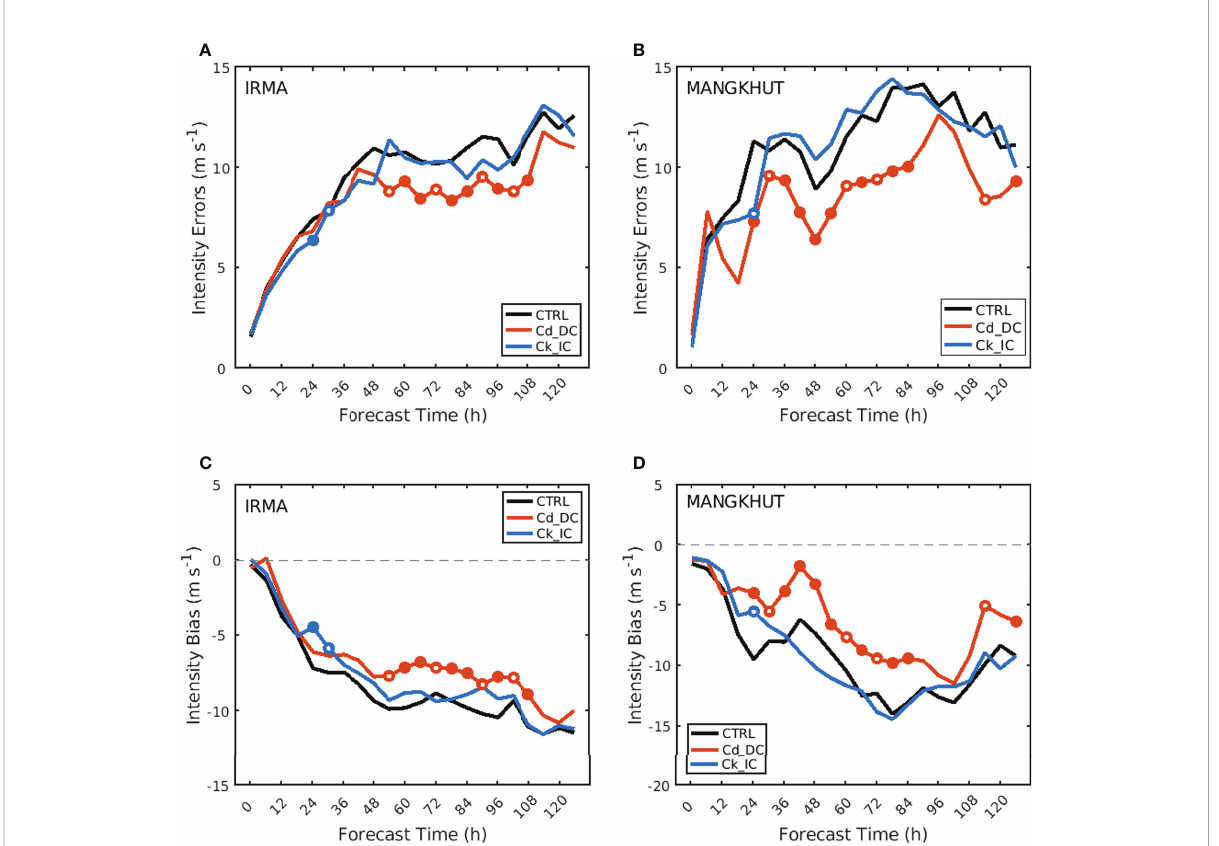
FIGURE 9 Comparisons of mean absolute error (A, B) and mean bias (C, D) against forecast lead time for three experiments, CTRL (black line), Cd_DC (red line), and Ck_IC (blue line), for Irma (A, C) and Mangkhut (B, D) . Red (blue) fi lled [open] circles indicate that the binned value for Cd_DC (Ck_IC) is signi fi cantly improved than for CTRL at the 99% [95%] con fi dence level (Student ’ s t